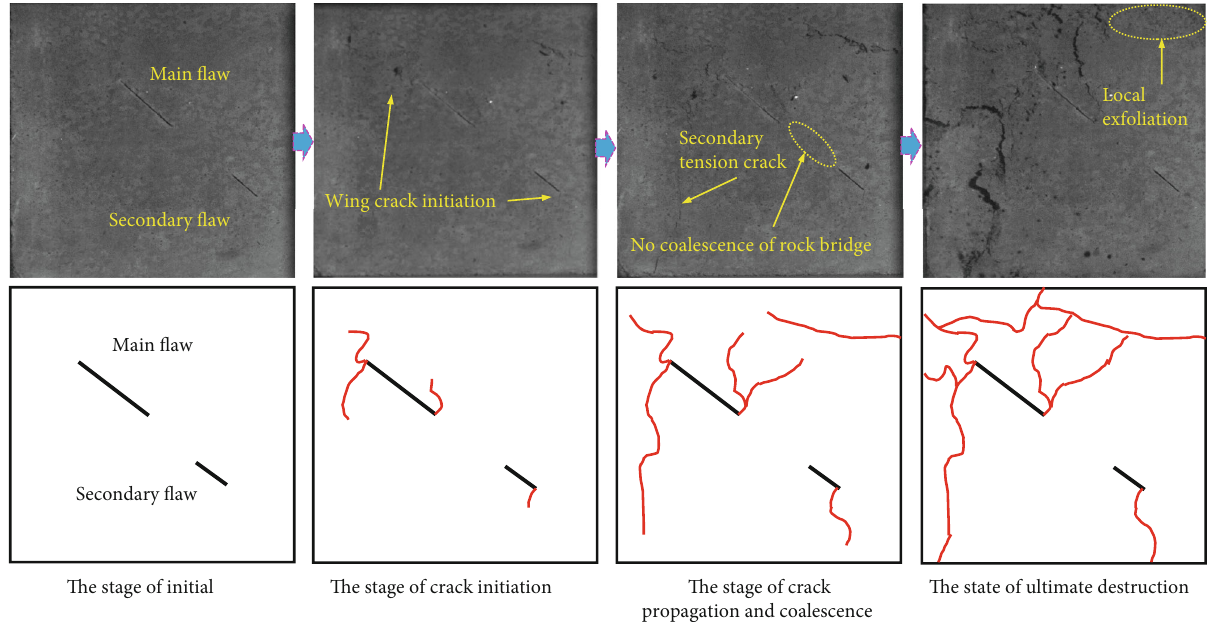
= 24 mm , 2 l = 12 mm , 2 d = 12 mm . 1 2